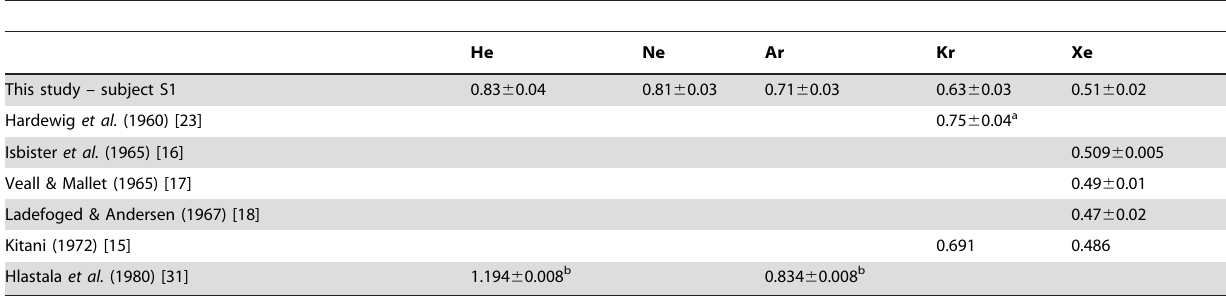
Table 2. Noble-gas partition coefficients between blood plasma and red blood cells as determined in this study for one subject (S1) compared with values from the relevant